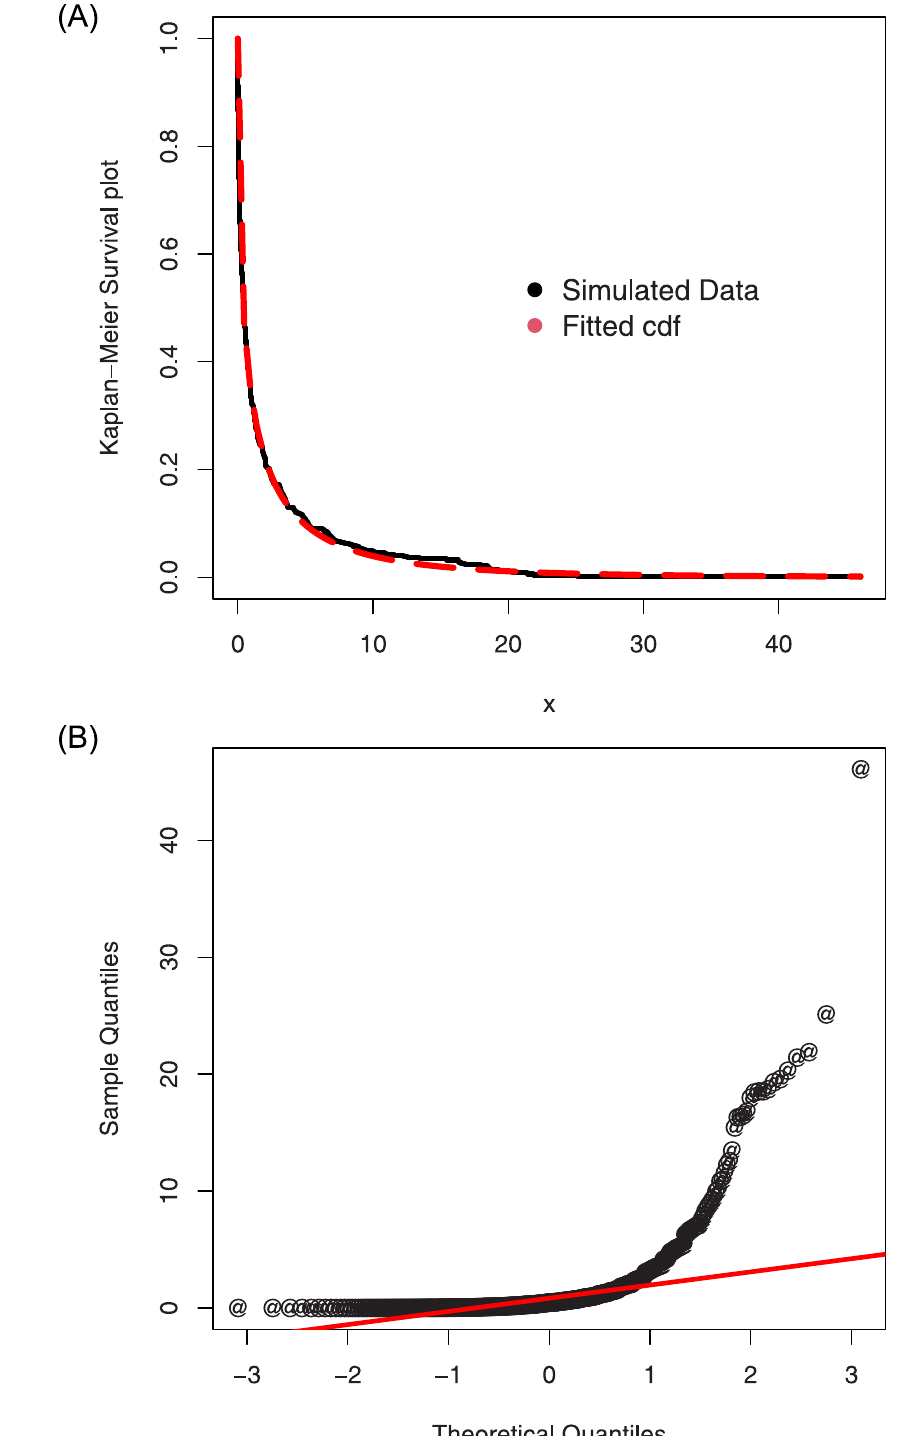
Fig 12. The QQ and Kaplan-Meier survival plots of the ASM-Weibull model for the simulated data set 2.